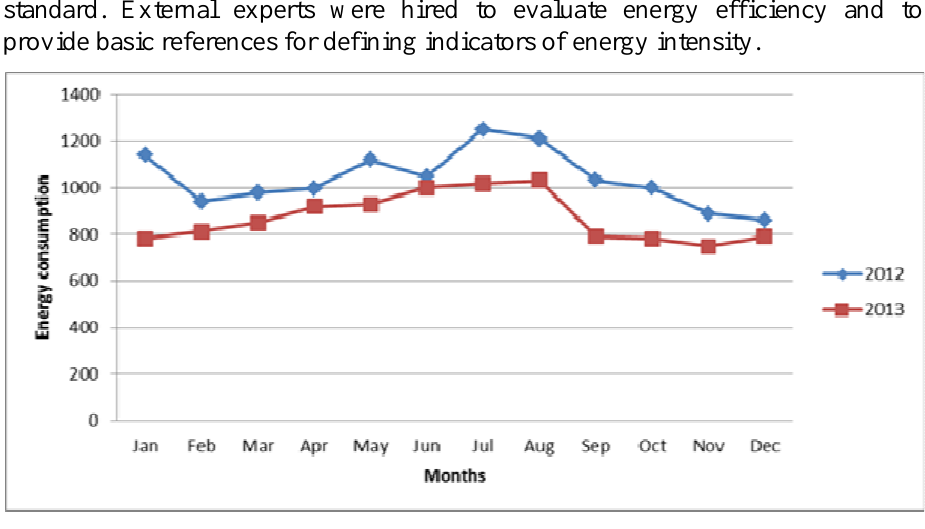
Figure 4 – Comparison of energy consumption before and after implementation of the energy management system model according to ISO 50001:2011 in 2012-